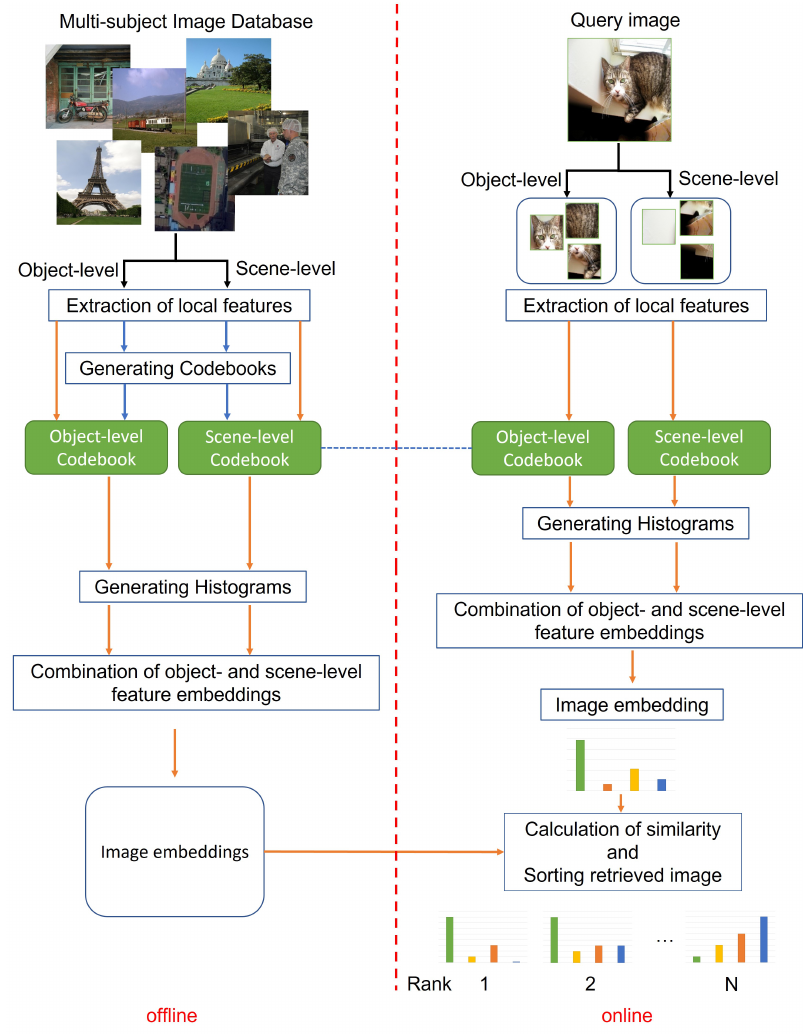
Figure 3. Algorithm flowchart for proposed image embedding.